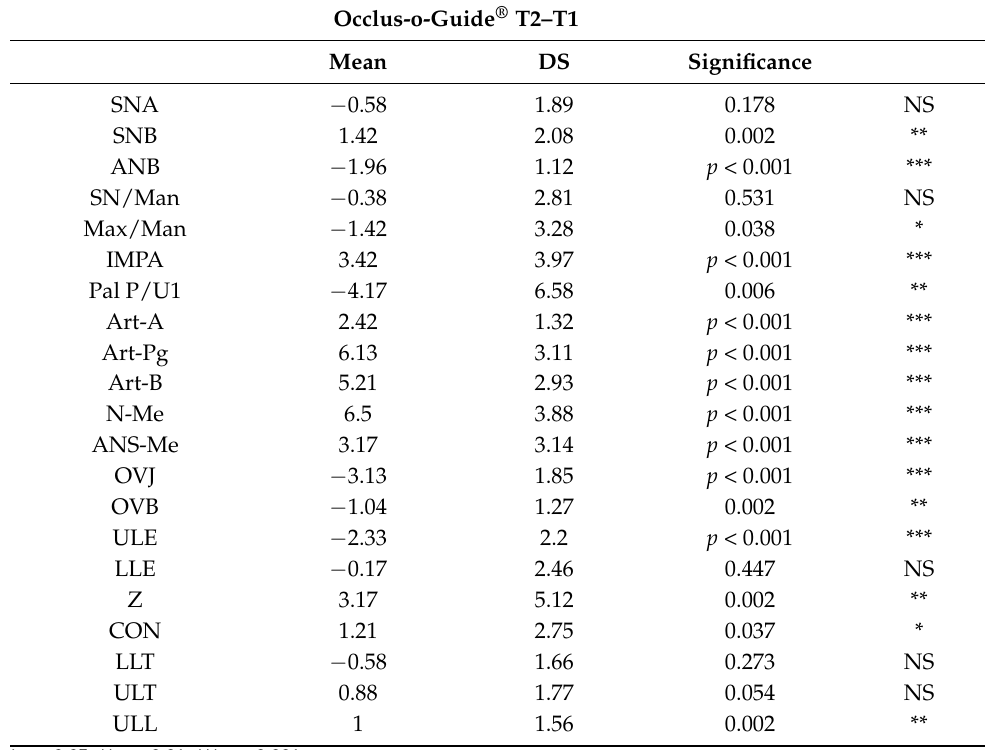
Table 5. Data collection of the differences in the variables considered between the time T1 and T2 for Occlus-o-Guide ® .